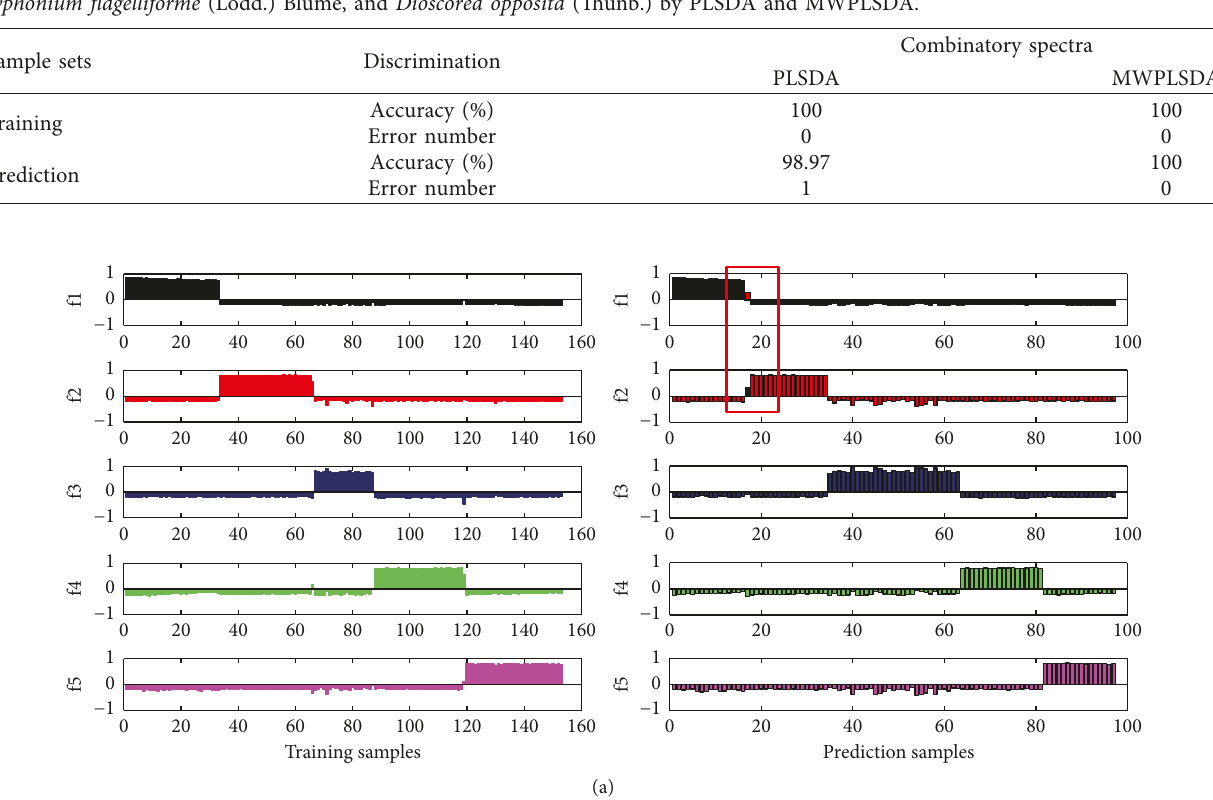
Figure 3: Data fusion of NIR and MIR spectroscopy for authenticity or adulteration discrimination of Corydalis yanhusuo W. T. Wang (a) and the residue line obtained by MWPLSDA for the training sets (b). Table 3: Forecasted results of NIR-MIR fusion spectra of two kinds of Corydalis yanhusuo W. T Wang, Corydalis decumbens (Thunb.)